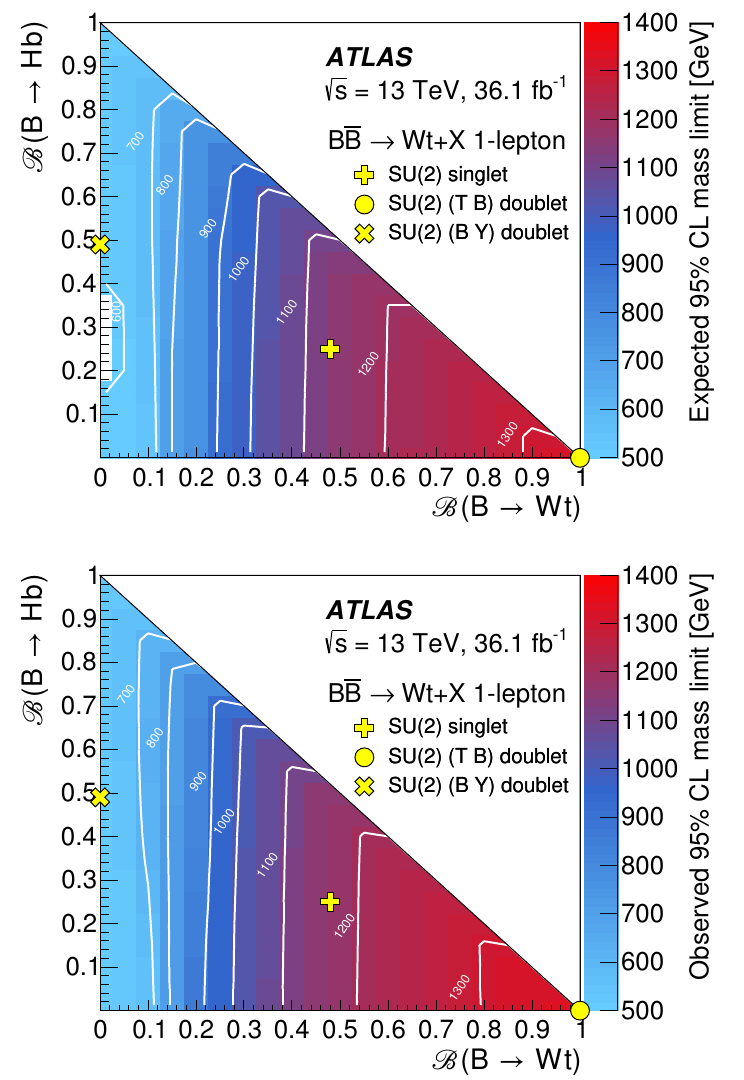
Figure 5 . Expected (top) and observed (bottom) 95% CL lower limits on the mass of the B quark as a function of the decay branching ratios represent constant mass limits. The markers indicate the branching ratios for the SU(2) singlet and both SU(2) doublet scenarios with masses above independent of the VLQ B mass. The small white region in the upper plot is due to the limit falling below 500 GeV, the lowest simulated signal